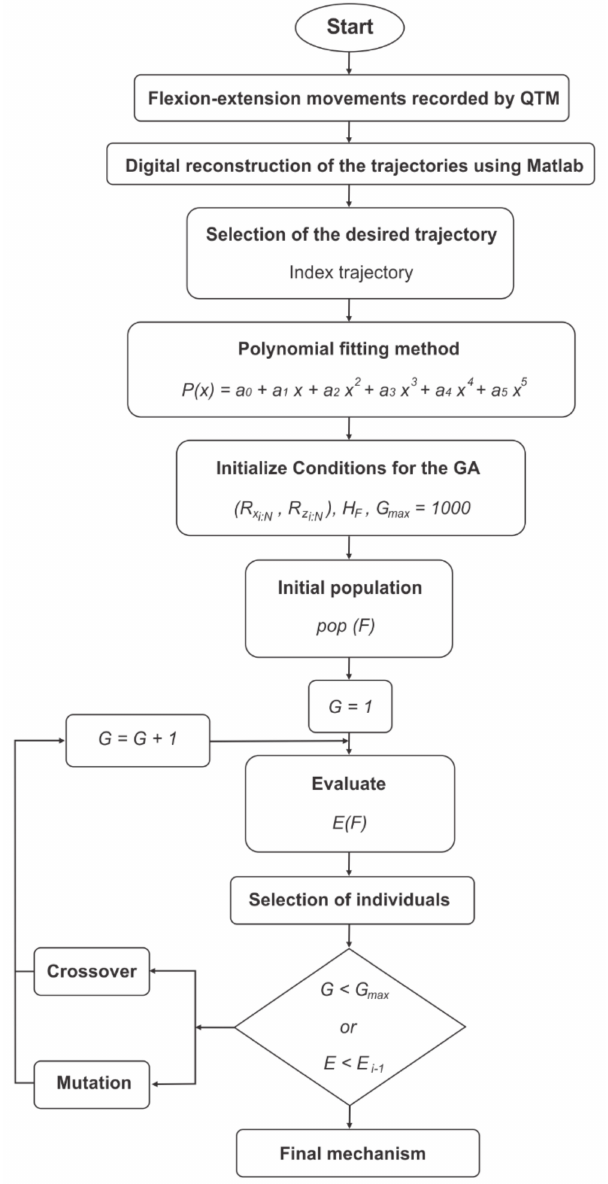
Figure 16. The optimal synthesis process of the rehabilitation device